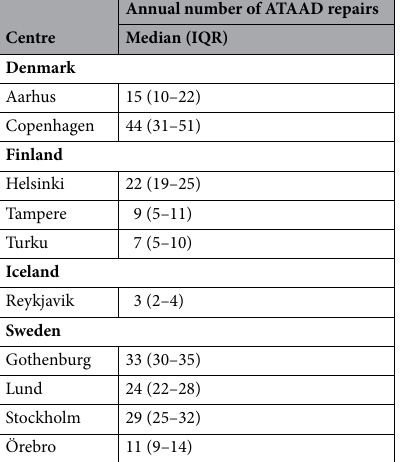
Table 1. Annual numbers of ATAAD repairs for the participating centres. ATAAD, Acute Type A Aortic Dissection; IQR, Interquartile